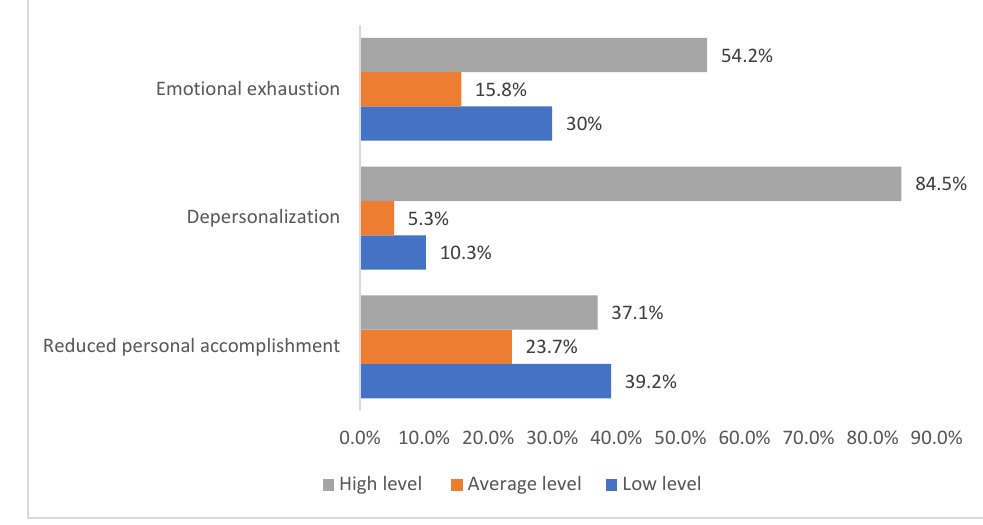
Figure 5. The frequency distribution of COVID-19 ICU nurses by the levels of severity of components of occupational burnout.